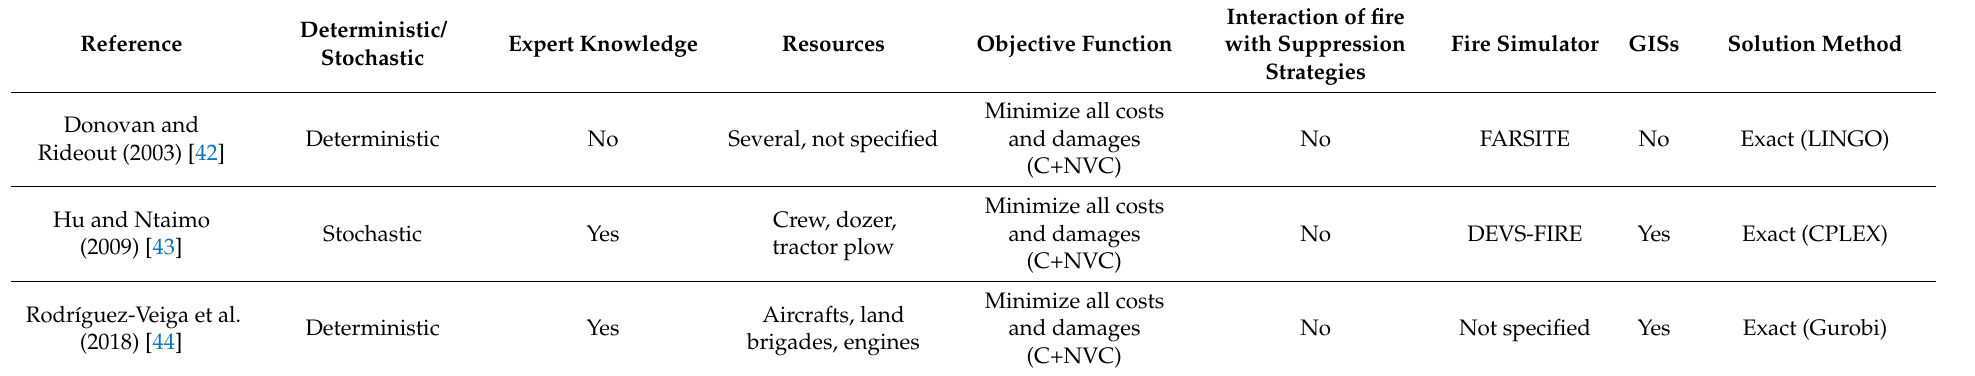
Table A2. List of main characteristics of papers that address the dispatch of resources for response.